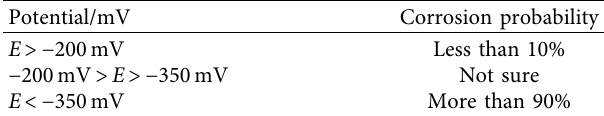
Table 4: Evaluation criteria for corrosion of the steel bar.